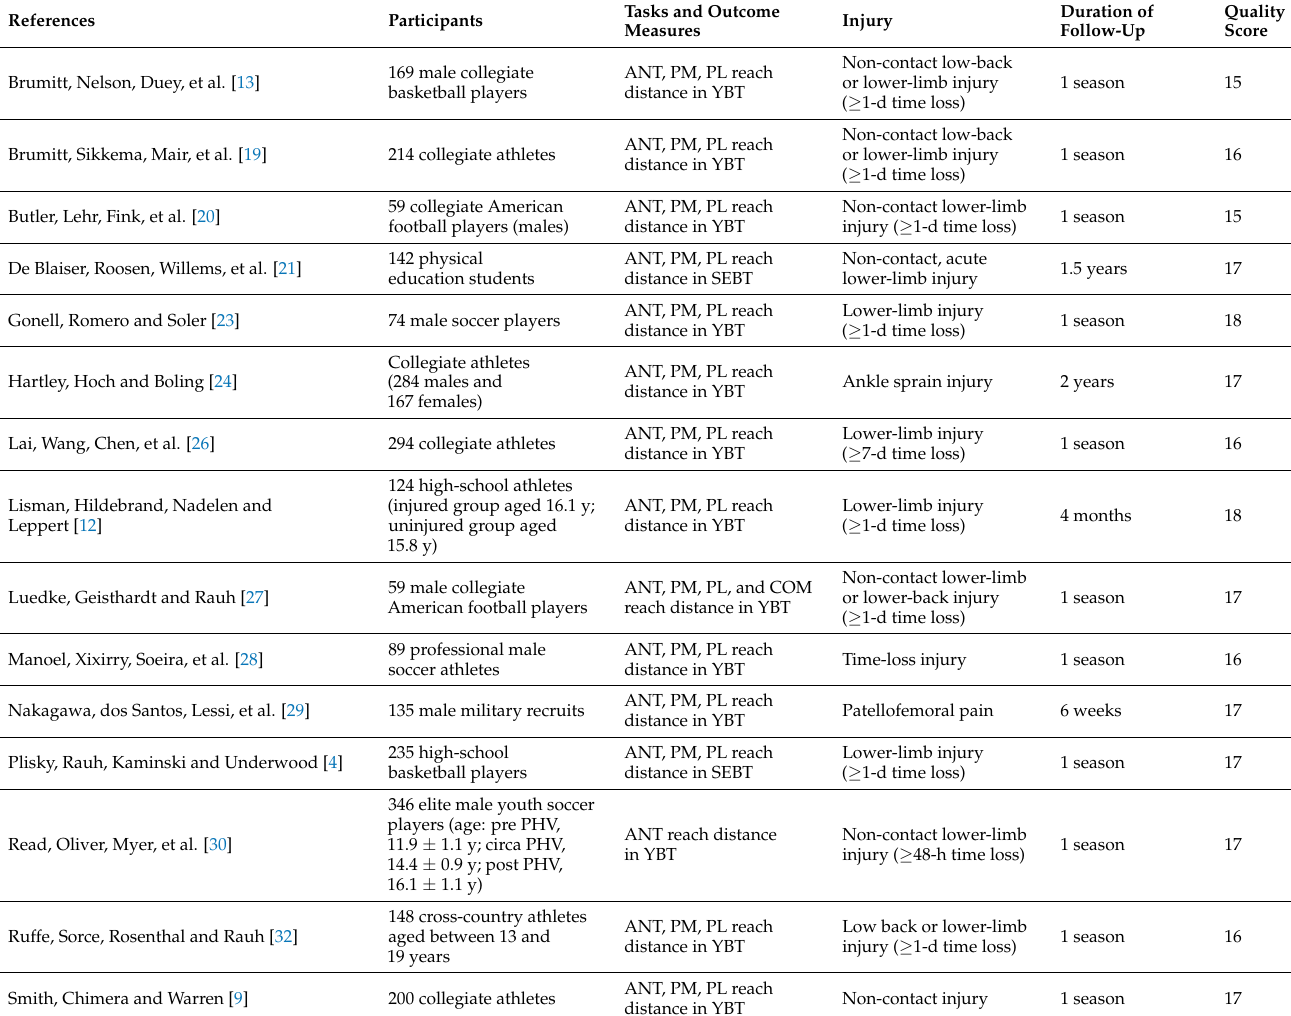
Table 3. Study characteristics—inter-limb asymmetries in dynamic